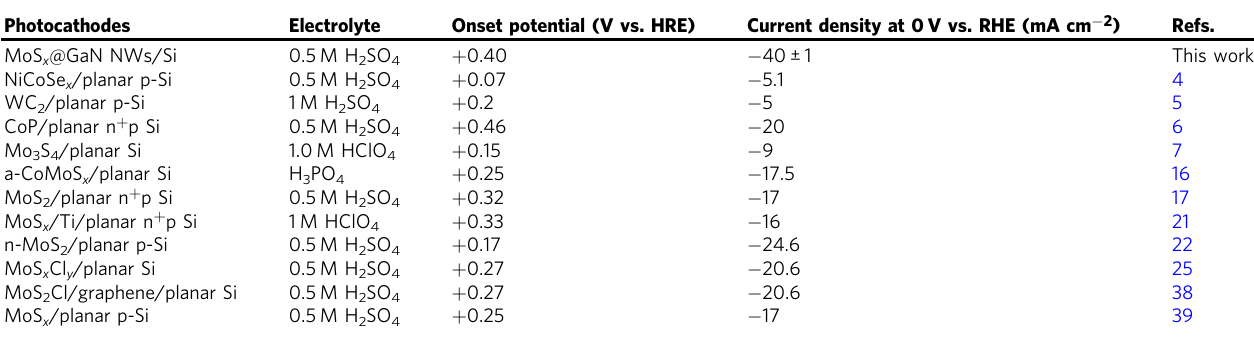
Table 1 The summary of planar silicon with non-noble-metal catalysts for water splitting Photocathodes Electrolyte Onset potential (V vs. HRE) Current density at 0 V vs. RHE (mA cm − 2 )